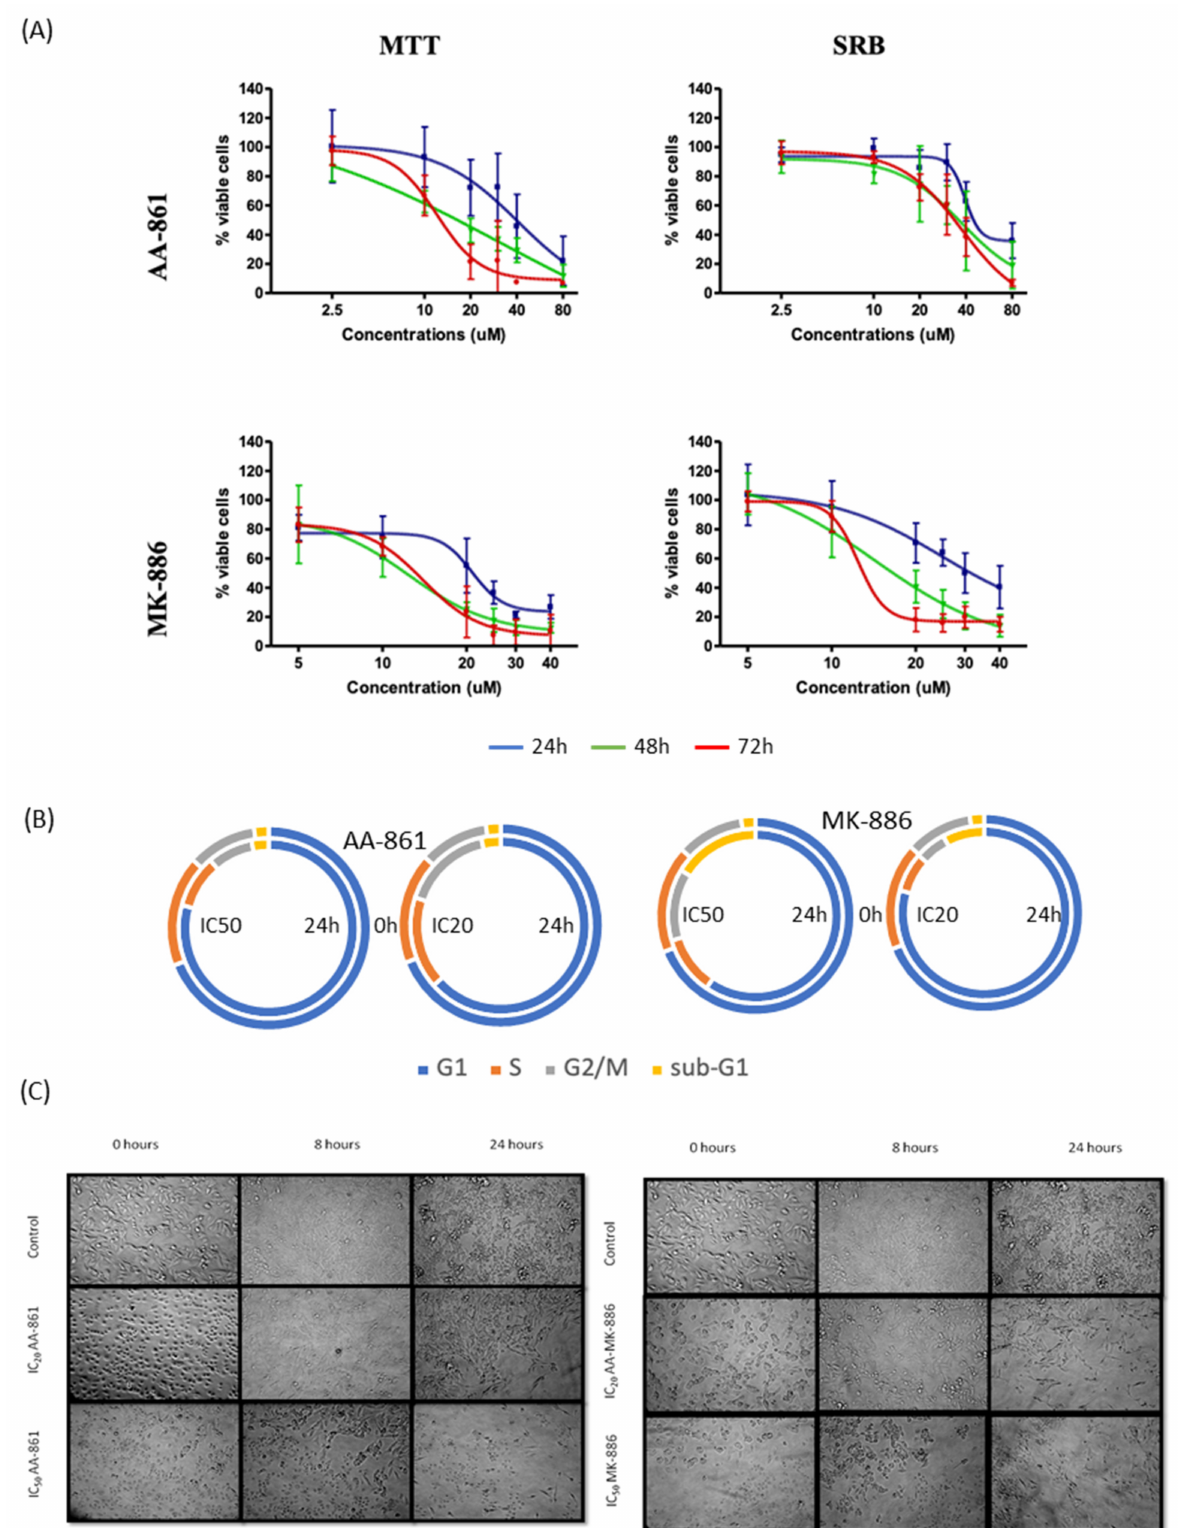
Figure 6. Effects of AA-861 and MK-886 on proliferation, mitochondrial viability and morphology of B16F10 cells. ( A ) Mito- chondrial viability (MTT assay) and antiproliferative (SRB assay). ( B ) Cell cycle distribution (%) after 24 h incubation with IC 20 and IC 50 of the inhibitors. ( C ) Cell morphology of treated cells. Values are the mean of three independent assays. Error bars represent SD. Statistical significance by two-tailed unpaired t